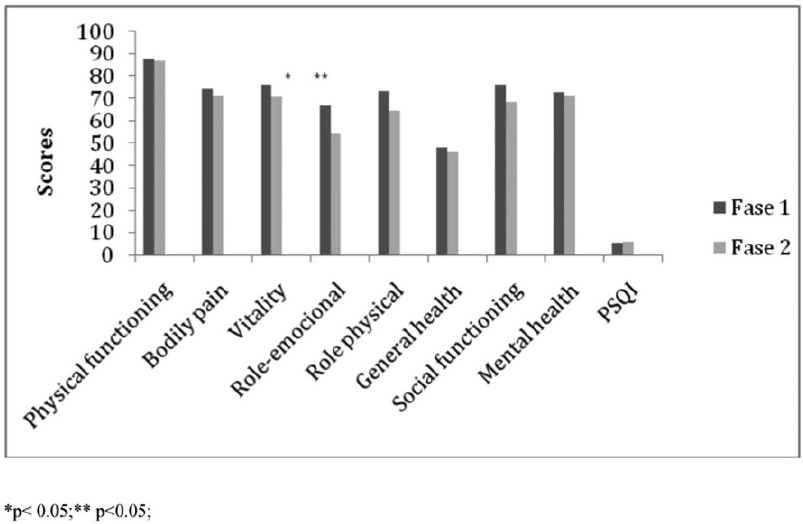
Figure 2 - Comparison of SF-36 domain and PSQI scores in Phase 1 vs . Phase 2.